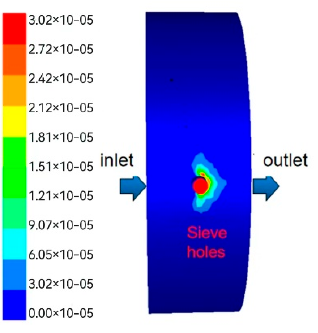
Figure 9. The contour of erosion rate in perforated screen.